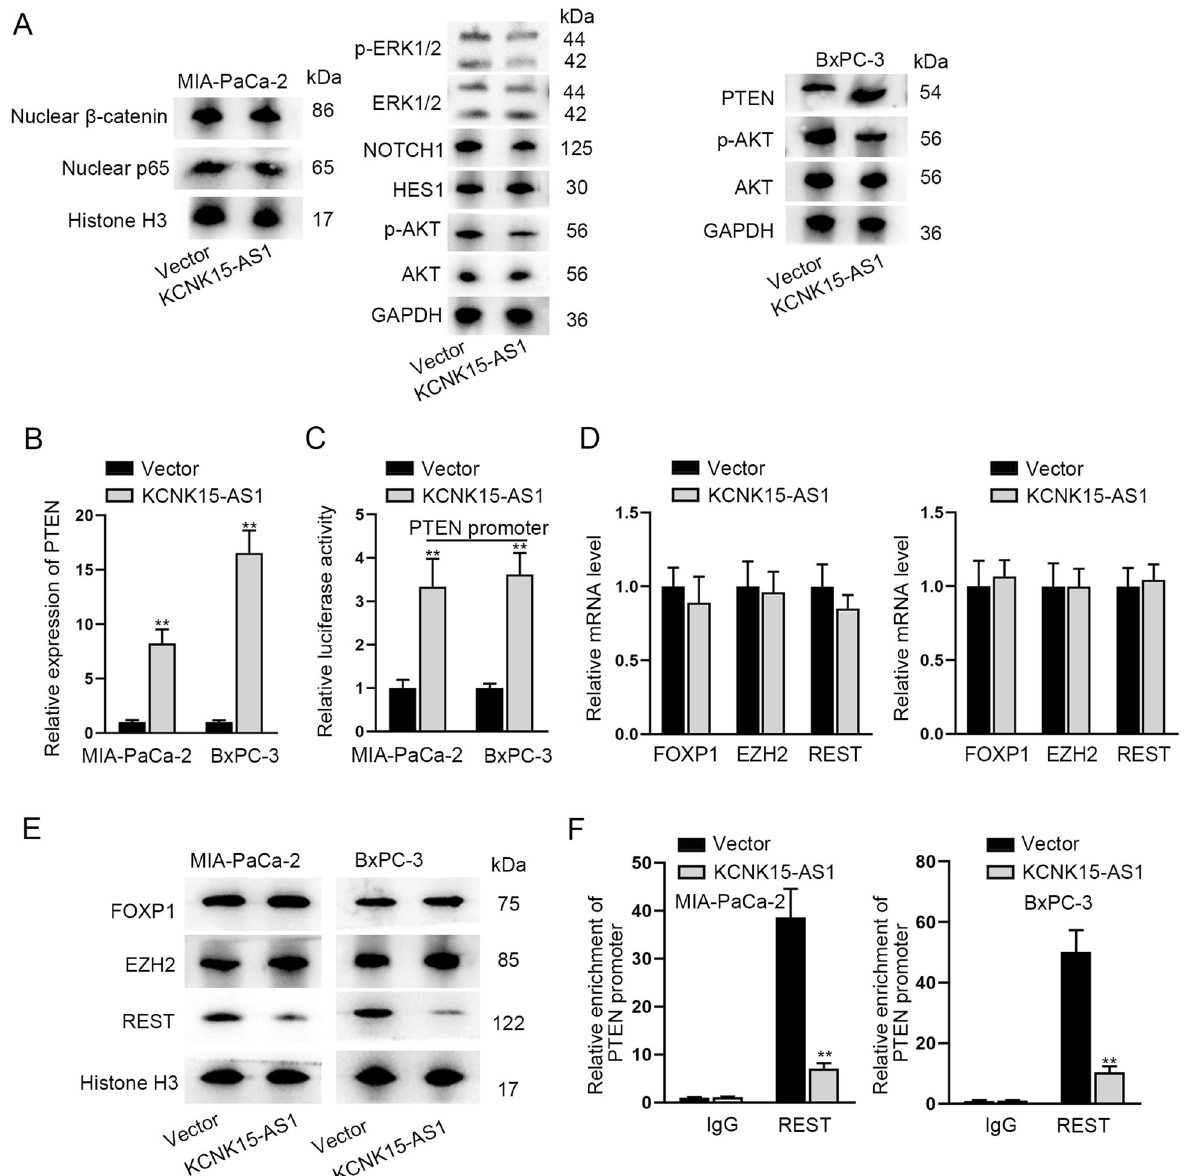
Fig. 5 KCNK15-AS1 inhibits REST to promote PTEN transcription and inactivate AKT pathway in PC cells. A Levels of key proteins in several signaling pathways were analyzed by western blot in PC cells after KCNK15-AS1 overexpression. B PTEN expression was analyzed using RT- qPCR in PC cells after KCNK15-AS1 overexpression. C Luciferase activity of PTEN promoter was detected in PC cells after KCNK15-AS1 overexpression. D , E In fl uence of KCNK15-AS1 on FOXP1, EZH2 and REST expression was detected using RT-qPCR and western blot. F Impact of KCNK15-AS1 on the binding of REST to PTEN promoter was measured via ChIP assays. ** P < (Fig. 5D, E). ChIP assay results validated that the interaction between REST and PTEN promoter was hindered by KCNK15-AS1 (Fig. 5F). Through JASPAR (http://jaspar.genereg.net), we found three REST binding sites in PTEN promoter, and then fragmented